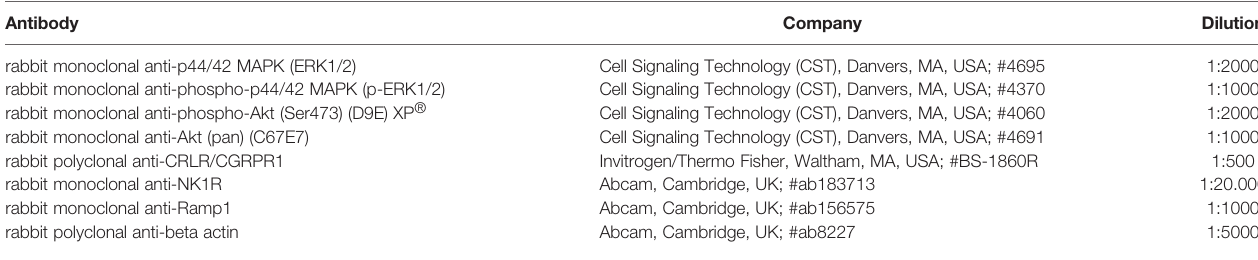
TABLE 1 | Antibodies used in this study. Antibody